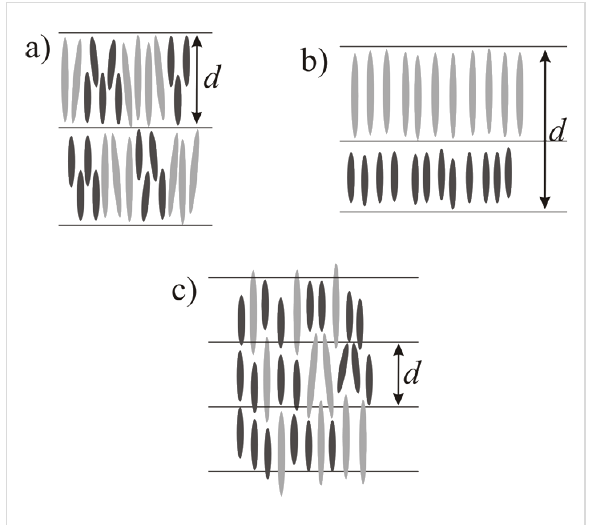
Figure 11: Schematic sketches of different models for smectic A ordering of bidisperse mesogens. Different models are: a) Intra-layer segregation, b) Inter-layer segregation or c) Out-of-layer fluctuations. After [5,18].